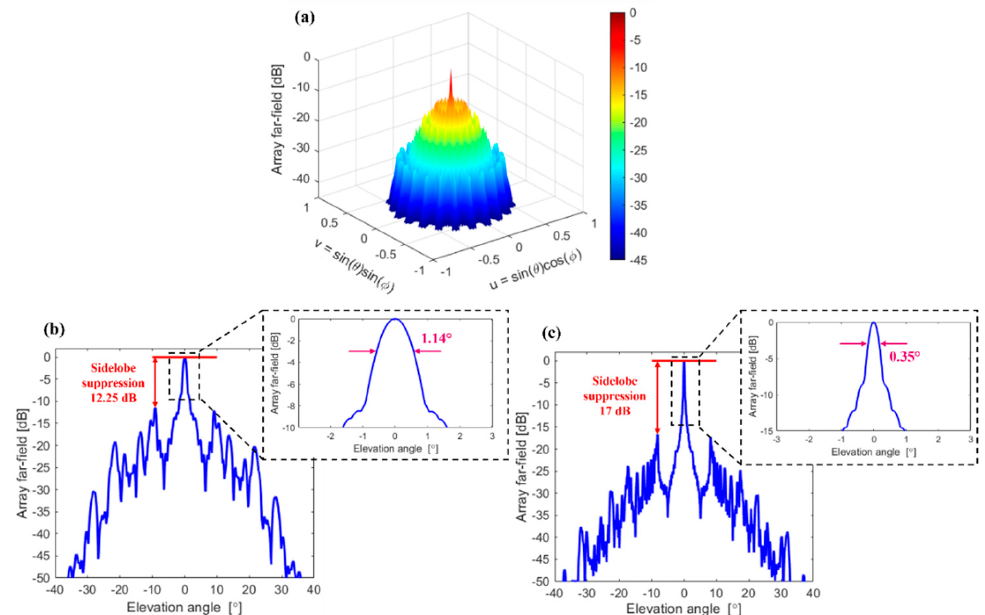
Figure 5. ( a ) Simulated far field of a radially configured circular OPA with parameters: N = 10, M = 11, R 0 = 75 µ m, and dr = 10 µ m, for θ 0 = 0 ◦ , φ 0 = 0 ◦ . Array far field is shown in a logarithmic scale. Elevation cut of simulated array far field for ( b ) N = 10, M = 11, R 0 = 75 µ m, and dr = 10 µ m and ( c ) N = 30, M = 29, R 0 = 96 µ m, and dr = 11 µ m. Elevation cuts correspond to θ 0 = 0 ◦ , φ 0 = 0 ◦ . Insets of ( b , c ): enlarged views of main lobes of array far field for an elevation angle range − 3 ◦ to 3 ◦